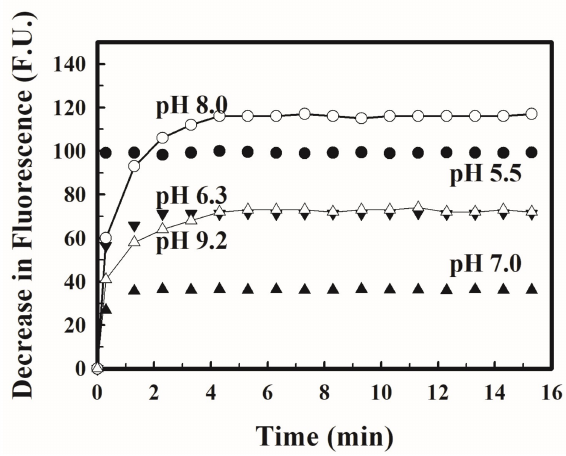
Figure 2. The time course of the decrease in the fluorescence, in fluorescence unit (f.u.) of the reaction mixture of H 2 O 2 and scopoletin at different pH. pH was adjusted by the addition of HCl and/or NaOH. ( : pH 5.5; (cid:78) : pH 6.3; (cid:72) : pH 7.0; : pH 8.0; (cid:52) : pH 9.2). Fluorescence at the different pH were not (cid:35)